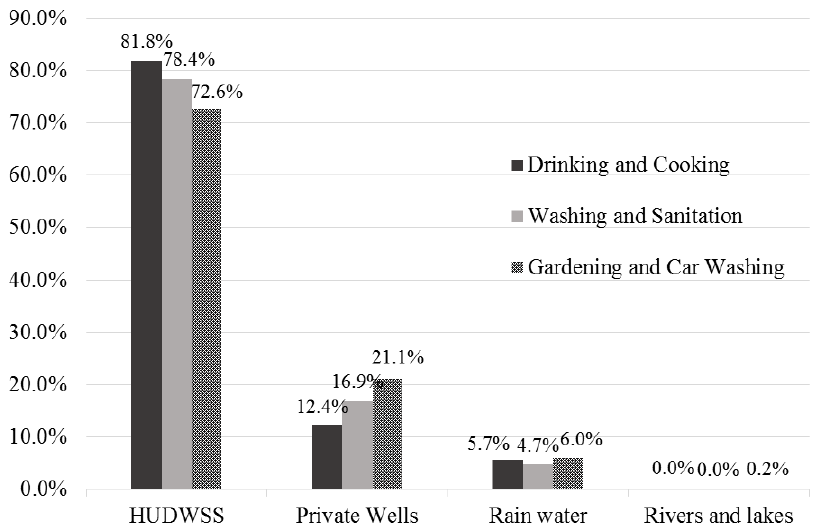
Figure 2. The main water sources used for basic purposes among the studied